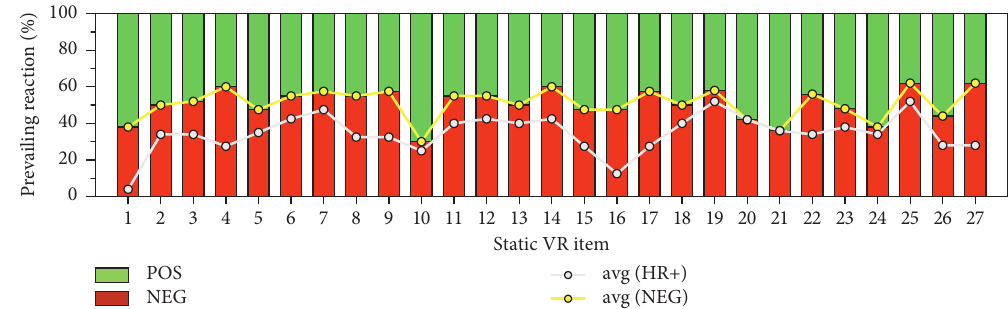
Figure 11: Detection of prevailing reactions (for the whole group of participants), as a function of the input stimulus, based on facial expression or heart rate data. In evidence, the discomfort of participants.